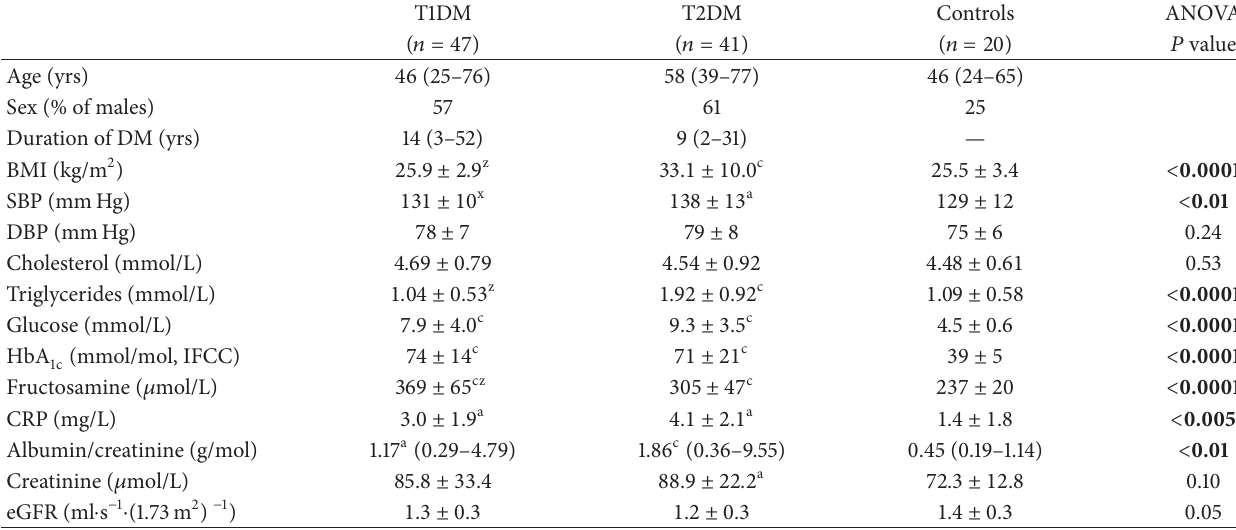
Table 1: Characteristics of patients with Type 1 (T1DM), Type 2 (T2DM), and controls.